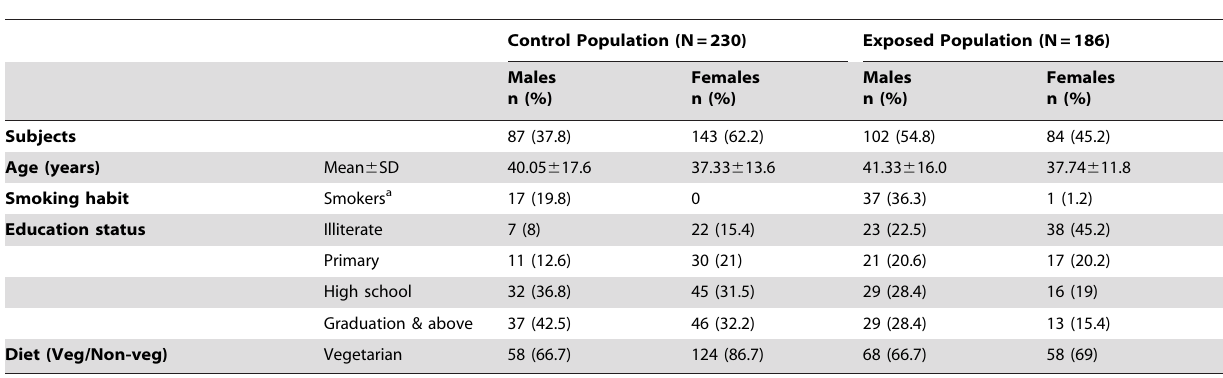
Table 1. Socio-demographic characteristics of the study population stratified by gender.